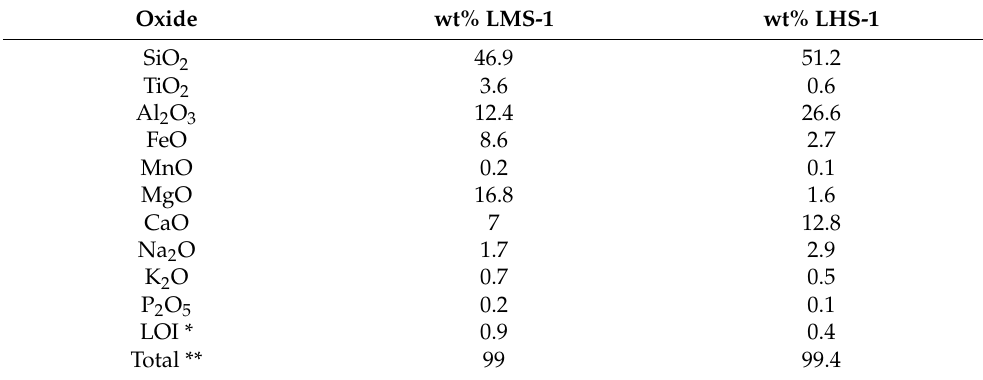
Table 1. Exolith regolith simulant composition as listed on the Exolith website [26].